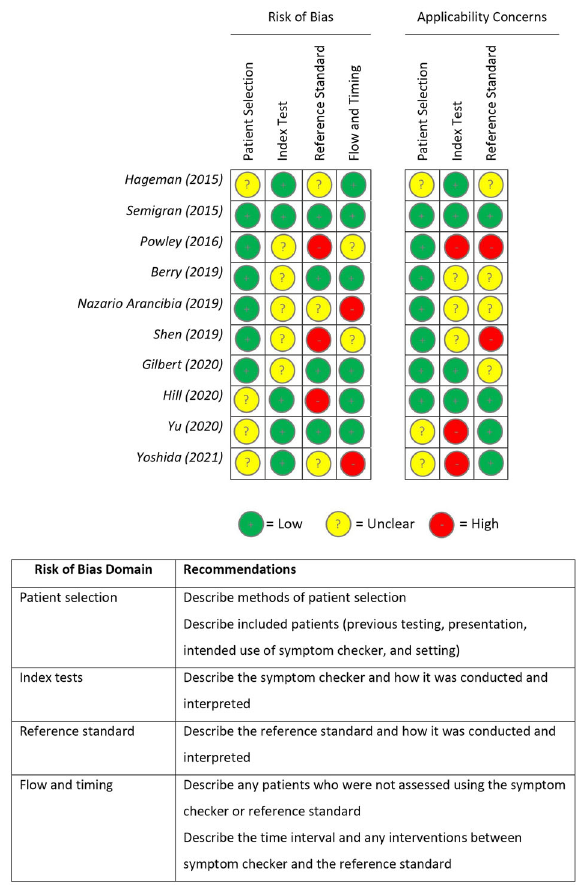
Fig. 2 Risk of bias summary using QUADAS-2 risk assessment tool 44 . Authors ’ judgement regarding each domain of bias of each study synthesised on the accuracy of symptom checkers. Risk was categorised into one of three categories: low risk ( + ), unclear risk (?) and high risk ( − ). The table shows possible items to consider in future work involving symptom checkers to achieve a low risk of bias or applicability